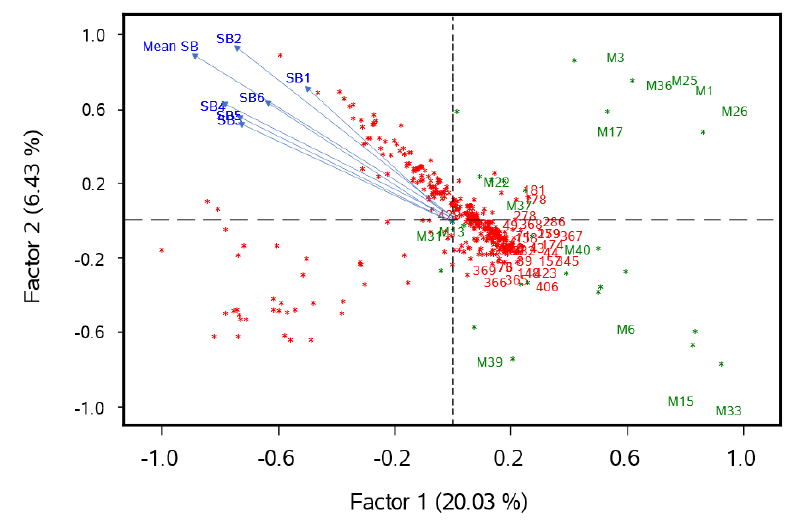
Figure 6. Biplot chart showing the first two PLS factors for 41 significant markers and 438 SHW lines, where SB measured in the greenhouse in six replicates (SB1-6) and overall mean (Mean SB) are shown (lines from the center to the upper right quadrant). The 15 molecular markers with a frequency of resistance alleles greater than 84% were M1 (4261287 chr1B), M3 (5582520 chr1B), M6 (1065667 chr1D), M13 (100031252 chr2B), M15 (2243785 chr2D or chr2B), M17 (1019955 chr3A or chr6B), M22 (1074984 chr3D), M25 (1162615 chr4A), M26 (100036641 chr 4A), M31 (1046932 chr 5A), M33 (1086529 chr5D or chr5A), M36 (1095642 chr7A), M37 (990293 chr7A), M39 (2245411 chr7D or chr2D), and M40 (1240012 chr7D or chr5B) (marker IDs are presented in Table 2). The 32 SHW lines having more than 32 resistance alleles are identified with red numbers. The remaining markers and SHW lines are represented by green and red dots, respectively.